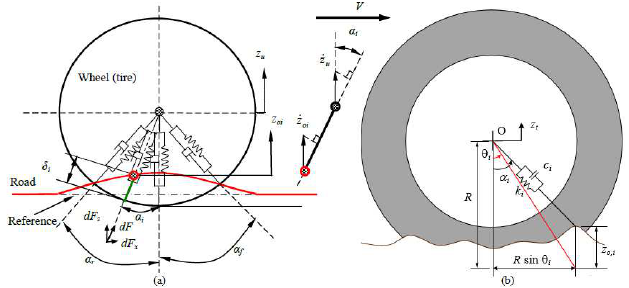
Fig. B.1. (a) Radial spring-dashpot tire-terrain model (adapted from [39]). (b) Individual spring-dashpot